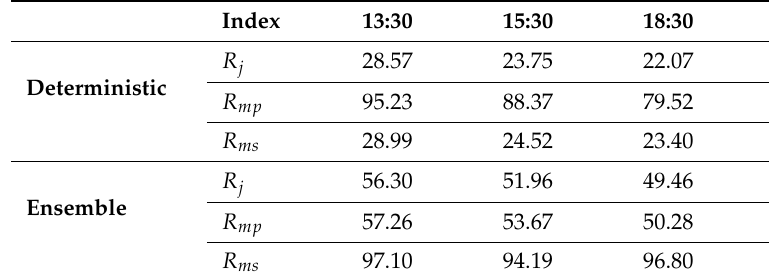
Figure 8. Same as Figure 7 but for the assimilation cycles performed at 16:30, 17:30 and 18:30. Panels ( a , d , g ) show the observation error (Observations). Panels ( b , e , h ) illustrate the standard deviation of ash columnar content as predicted by the numerical model PLUME-MoM&HYSPLIT (Forecast state), while Panels ( c , f , i ) present the standard deviation resulting from the assimilation cycles (Analyzed state). Table 3. Indices R j , R mp and R ms calculated for the deterministic and the ensemble simulations performed without